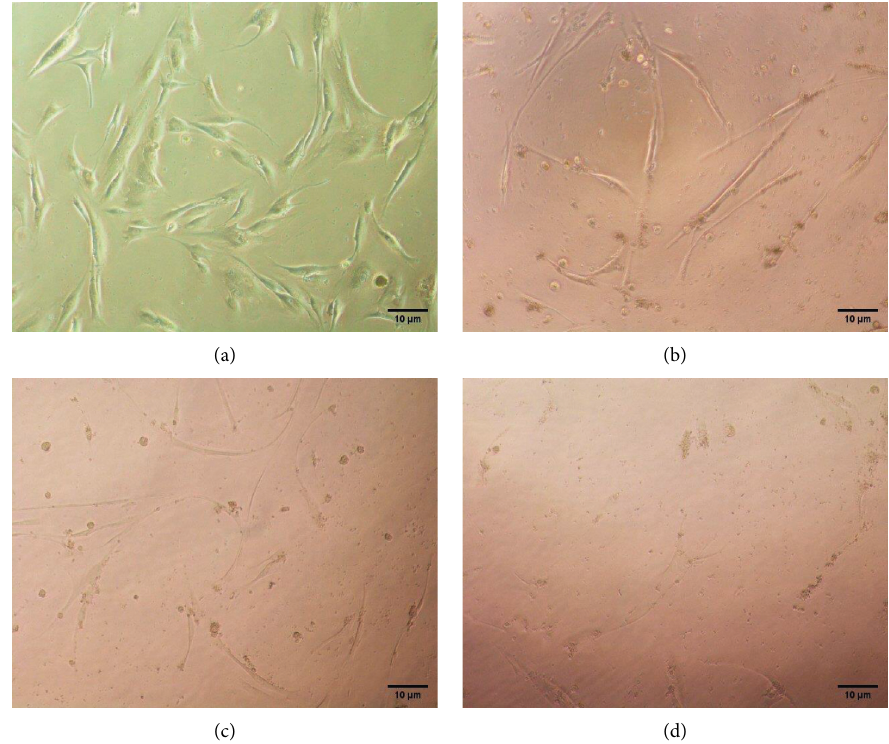
Figure 2: Microscopic examination ( × 40, scale 10 μ M) showing the cytotoxic effect of some samples on hGF normal cells treated (72 h) with